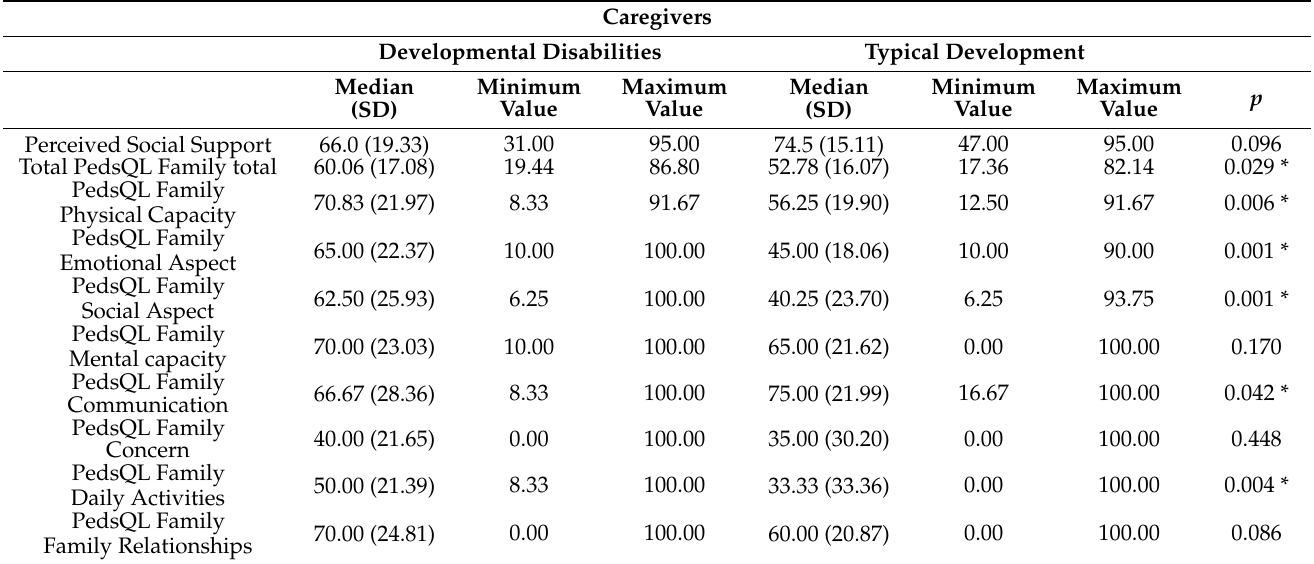
Table 3. Comparison between the children with DD and TD for perceived social support and caregivers’ QoL.